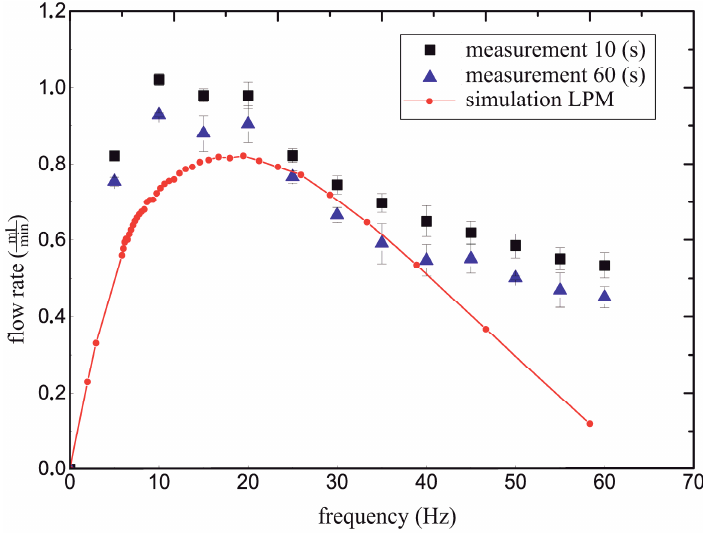
Figure 12. Comparison of the frequency dependence of the simulated and measured